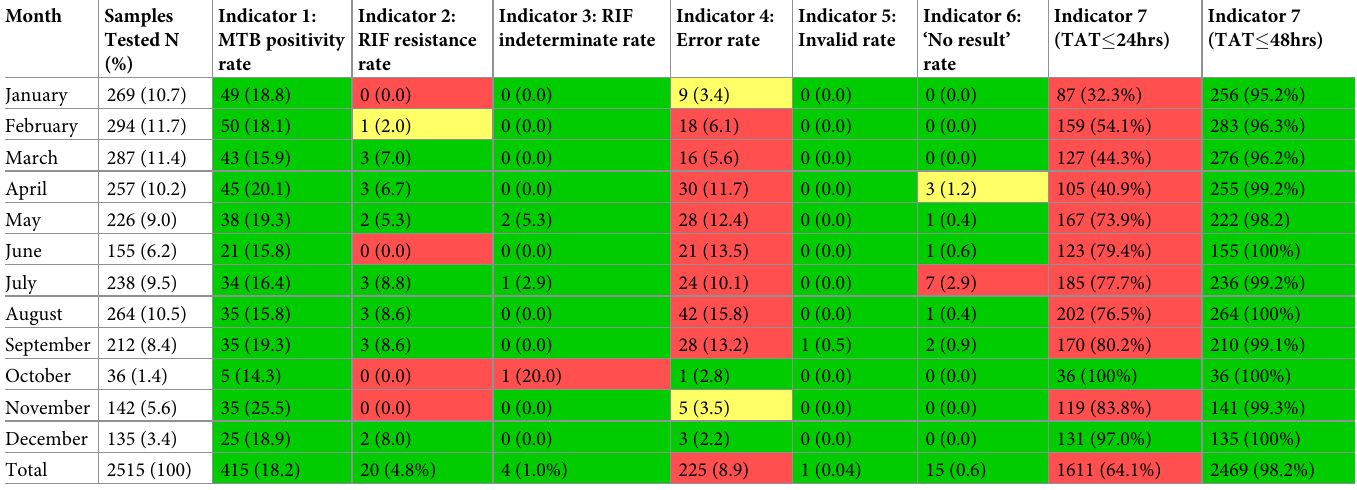
Green: within the target; Yellow: around the margin of the target; Red: above the target Indicators 1–7: calculated as per the definitions in Table